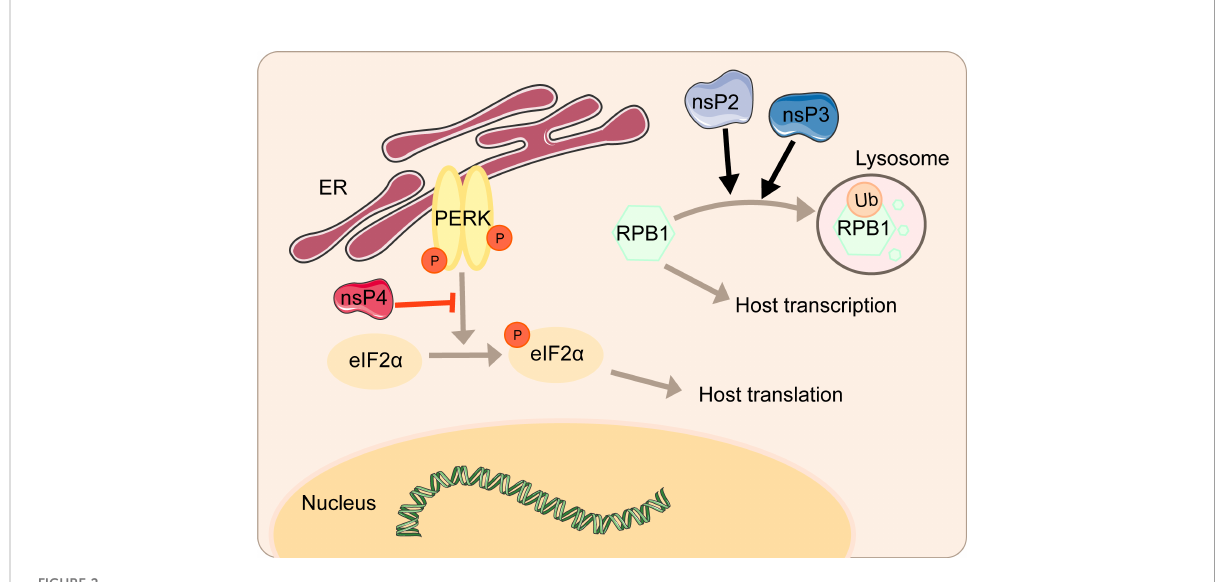
FIGURE 2 Inhibition of host transcriptional and translational shutoff by